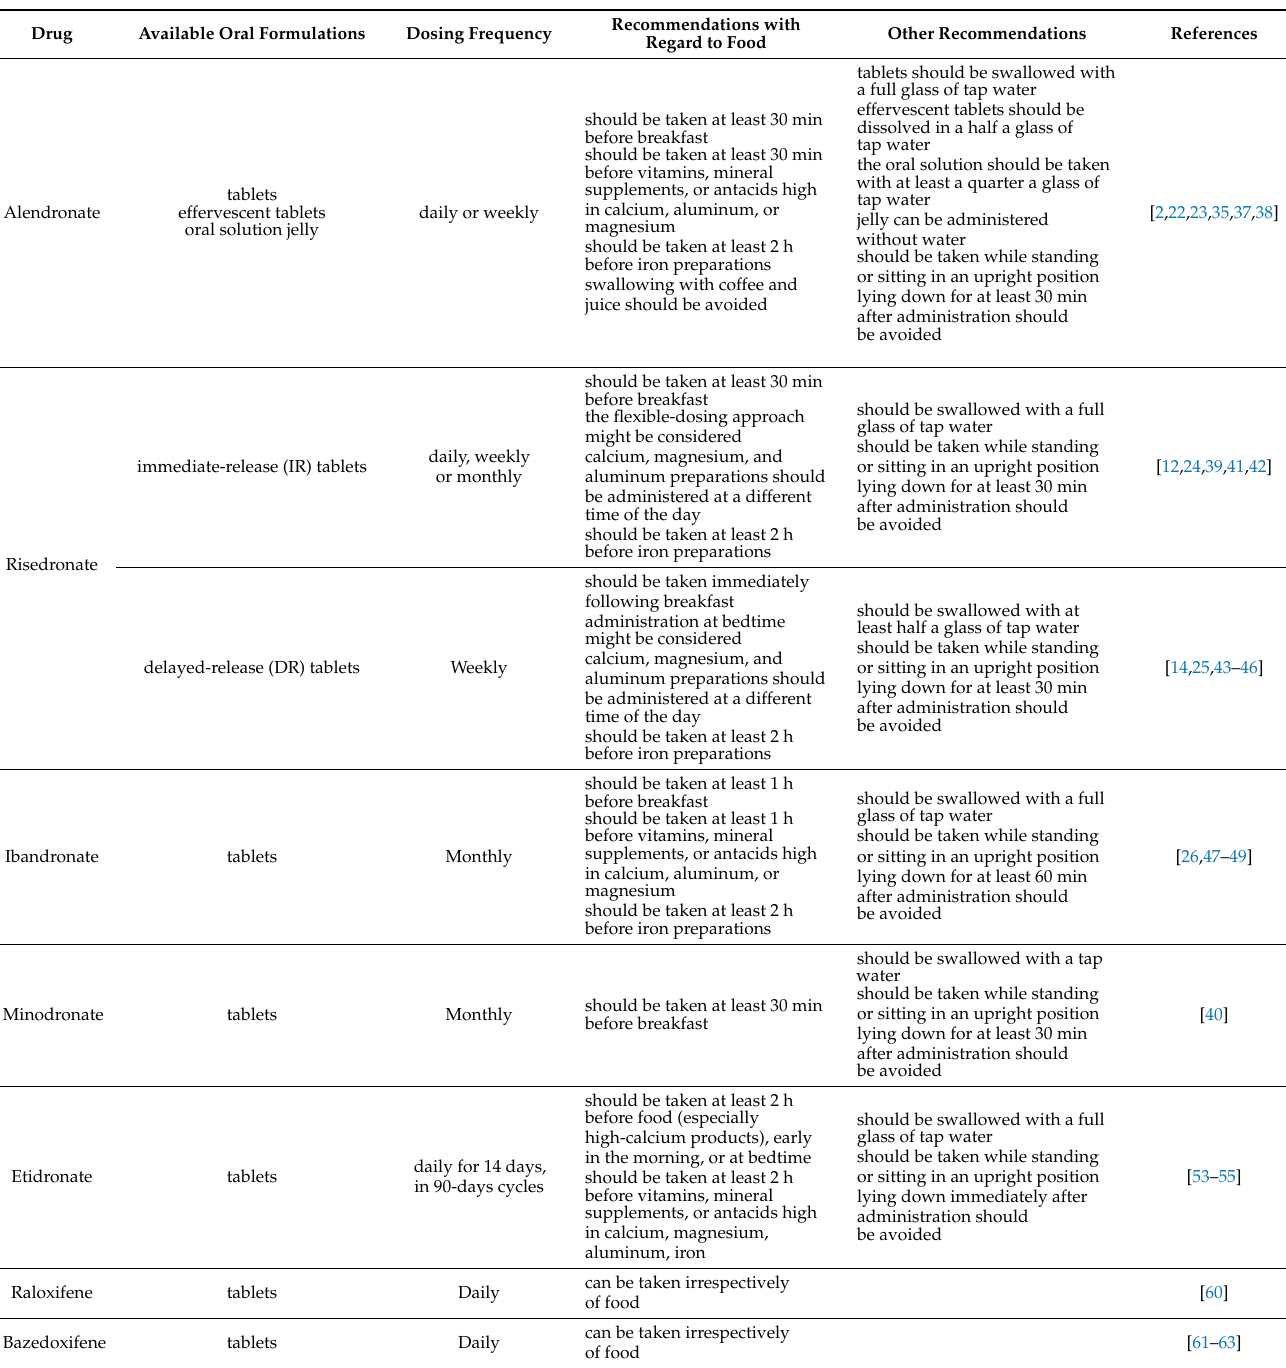
Table 2. The summary of recommendations for appropriate intake of drugs employed in treating osteoporosis with regard to